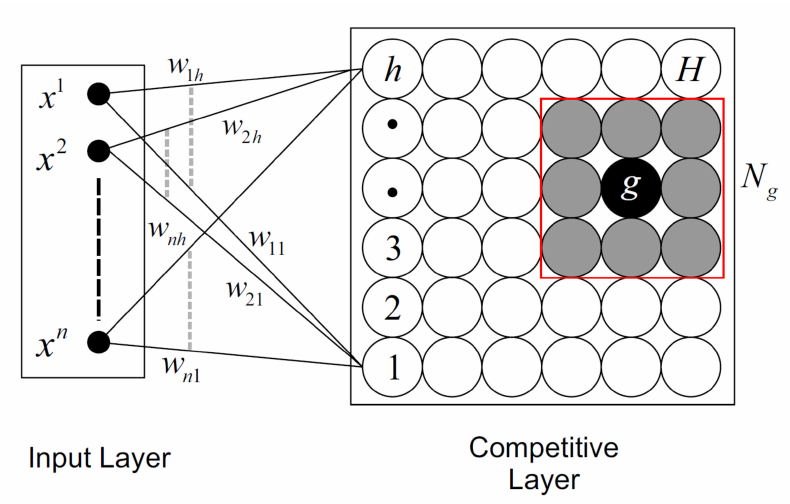
Figure 3. Representation of a SOM.